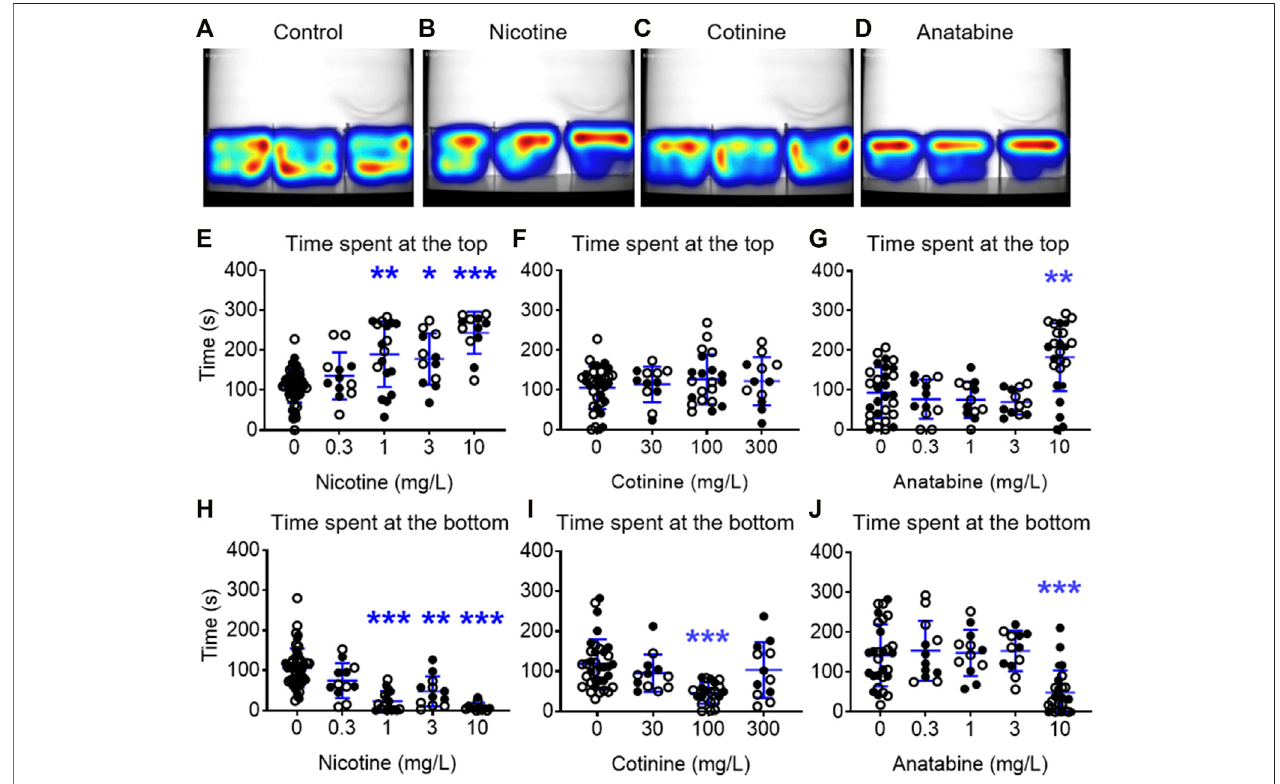
FIGURE2| Effectsofalkaloidsonanxiety-likebehaviorinzebra fi sh.Heatmapsofthegeneralactivityofzebra fi shafter (A) vehicle, (B) nicotine(1 mg/L), (C) cotinine (100 mg/L), or (D) anatabine (10 mg/L) treatment are shown. Nicotine increased the time spent at the top and decreased the time spent at the bottom for the three highest doses, 1, 3, and 10 mg/L (E, H) . Cotinine decreased the time spent at the bottom only at 100 mg/L and did not affect the time spent at the top (F, I) . Anatabine increasedthetimespentatthetopanddecreasedthetimespentatthebottomatonlythehighestdosetested(10 mg/L; (G,J) .Eachindividualcirclerepresentone zebra fi sh. Solid circles = males; open circles = females; n = 12 – 36; * p < 0.05 and *** p < 0.001. Data are presented as mean ±